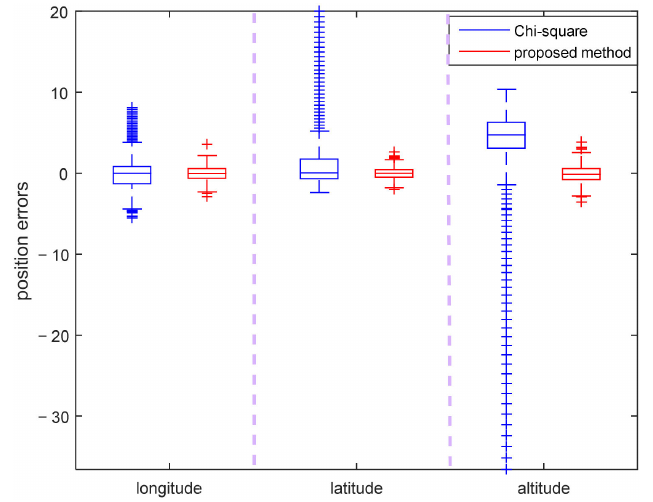
Figure 7. The box diagram of fused position errors under the single-satellite step fault. Table 4. RMS of navigation errors obtained by simulation under the single-satellite step fault.